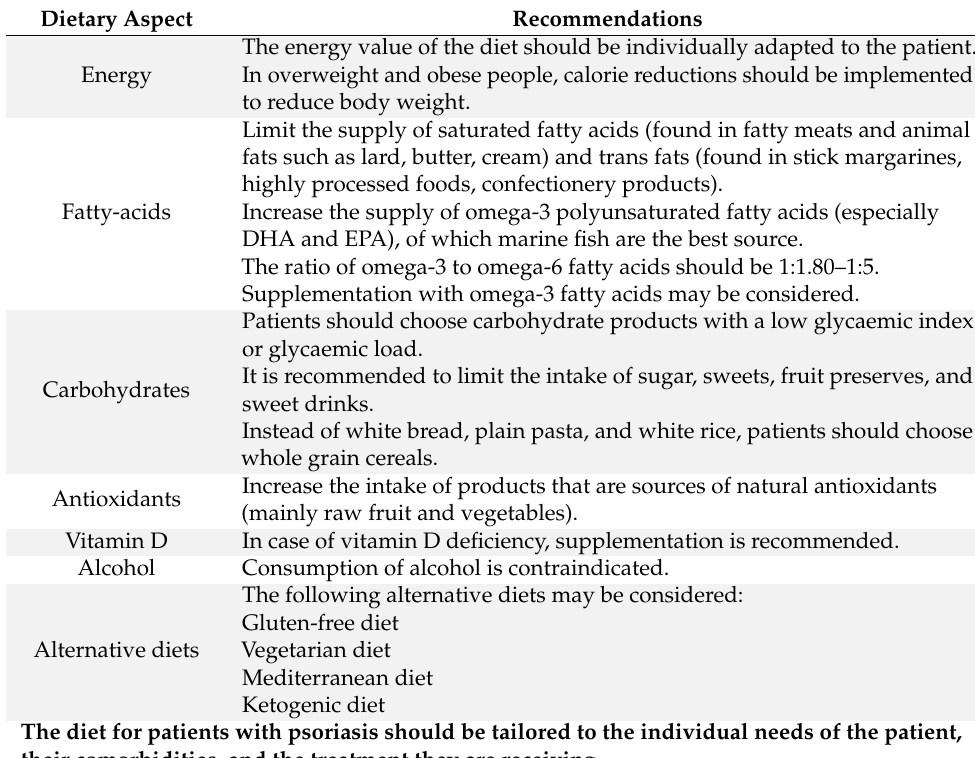
Table 2. Summary of dietary recommendations for patients with psoriasis. Dietary